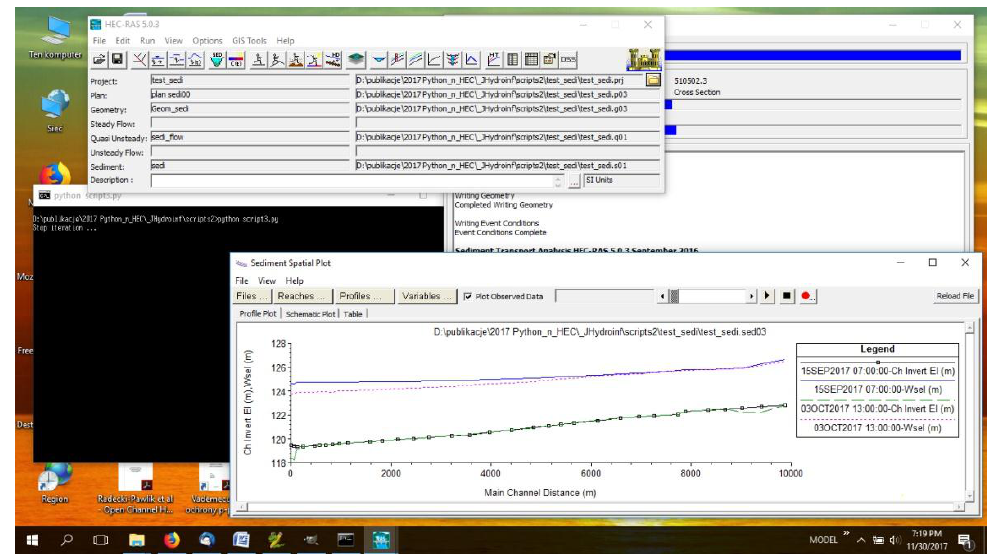
Figure 7. Run of sediment simulation and typical display of sediment output. Figure 8. Run of sediment simulation and typical display of sediment